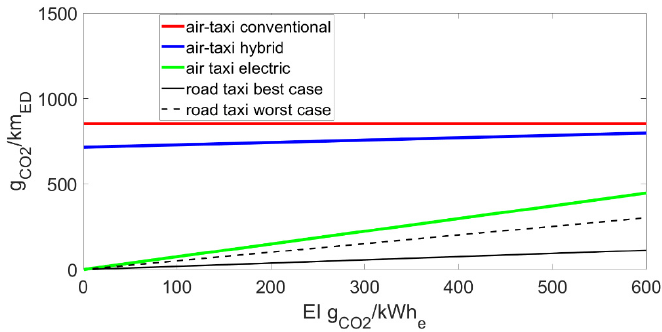
Figure 7. Comparison of WTW emissions of CO 2 per km of Euclidean distance with 2035 technology.